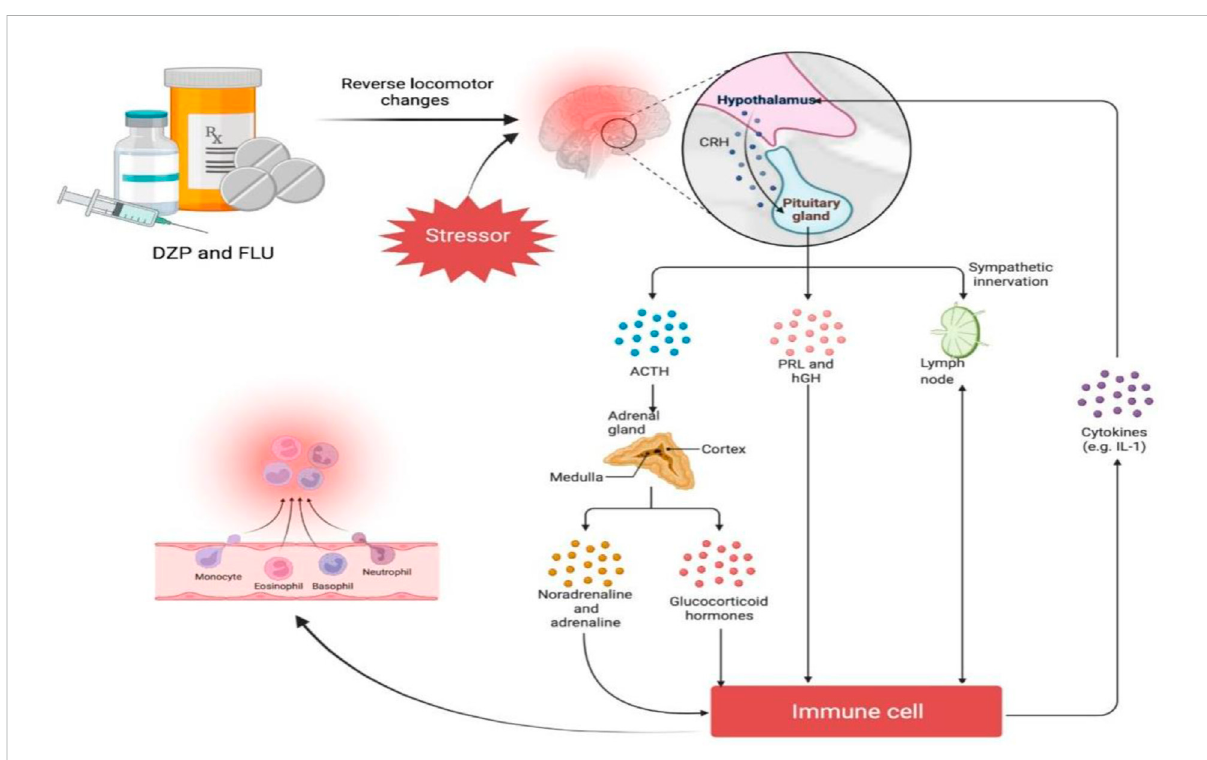
FIGURE 10 The acute stress protocol induced locomotor changes that were reversed by diazepam (DZP) and fl uoxetine treatments (FLU). The hypothalamic-pituitary-adrenal (HPA) axis results in a rise of corticosteroids levels in the blood, which are subsequently delivered to the spleen and periphery,wheretheydecreaseanumberofimmuneprocesses.FLUandDZPbothcantoactasanxiolyticsbydecreasingcortisolresponsestoacute stress. Abbreviations: ACTH, Adrenocorticotropin; PRL, Prolactin; hGH, human growth hormone; IL-1,